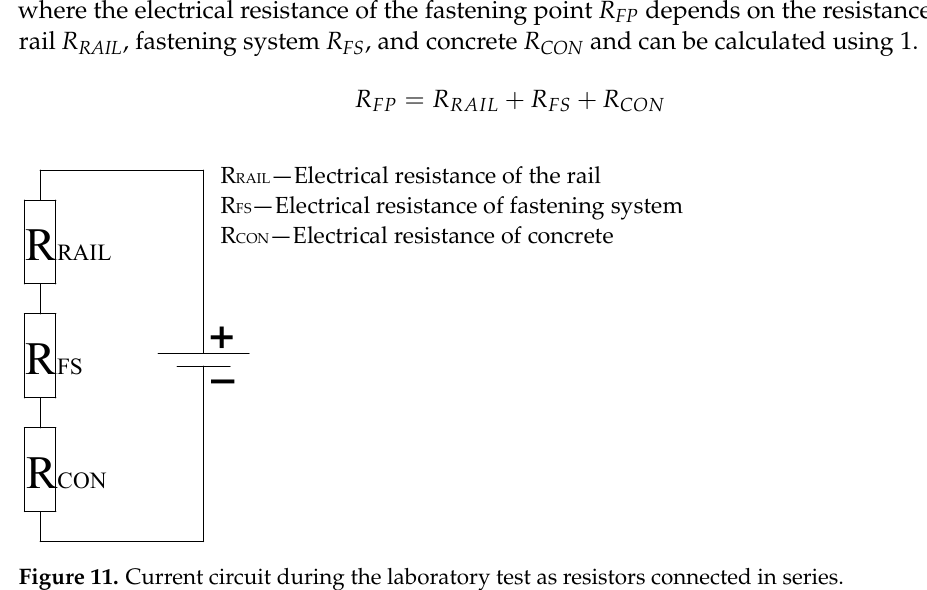
Figure 10. Current circuit during the test.